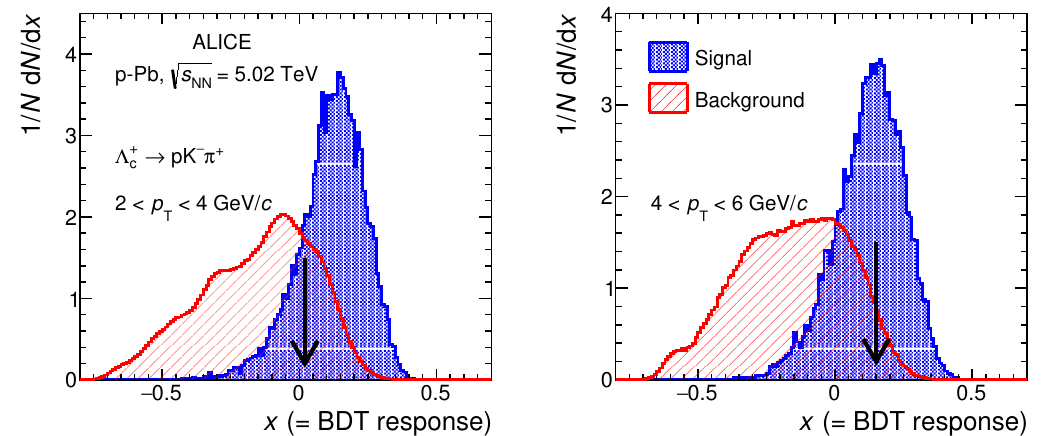
Figure 2 . Normalised distribution of the BDT responses of the (cid:3) c candidates for Monte Carlo signal (blue area) and background (red shaded area) in two p T intervals for the (cid:3) + decay channel in p-Pb collisions where the MVA method was used. The arrows correspond to the applied